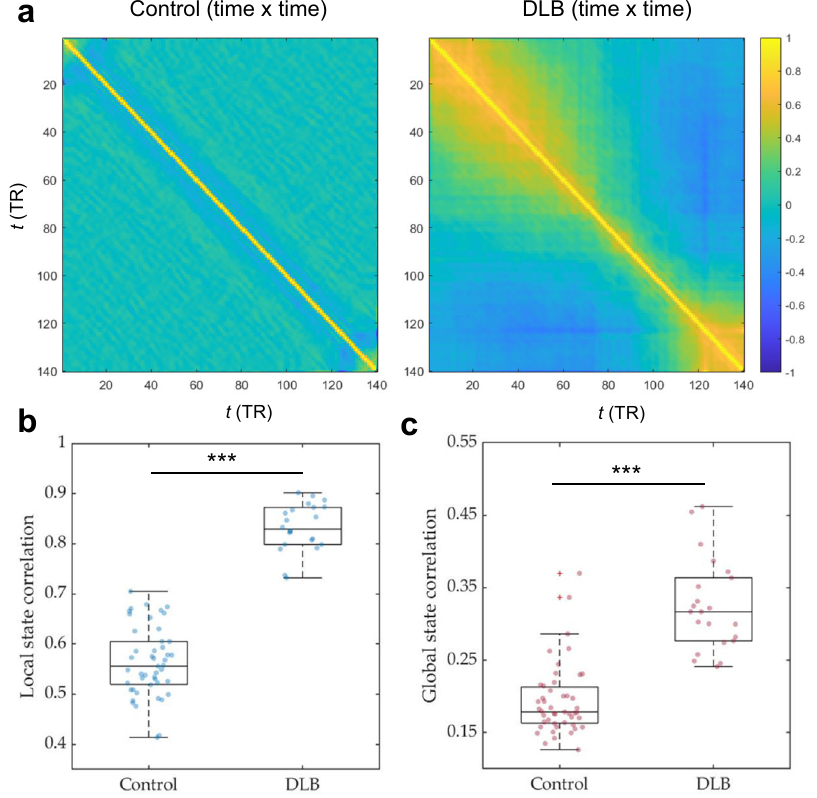
Fig. 1 DLB is characterised by more invariant dynamics at a macroscopic level which is de fi ned by higher intertemporal correlation of brain connectivity state con fi gurations. This is visually depicted by the time-to-time correlation matrices ( a ) for controls (left panel) and patients with DLB (right panel) and displays the coef fi cient of correlation of the functional connectivity network between any two time points averaged across all regions. This information is captured quantitatively by the summary statistics displayed in the boxplots below. b Patients with DLB demonstrate signi fi cantly increased local Similarity (S L ; correlation of network state between all contiguous time points) compared to control subjects. c Patients with DLB also exhibit higher global similarity (S G ; network state correlations across all time points) relative to controls. *** P < 0.001,